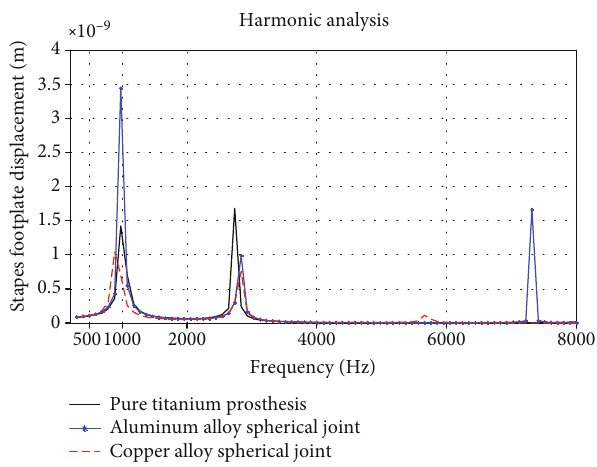
Figure 14: Three di ff erent structural types of prosthesis-complex harmonic response analysis